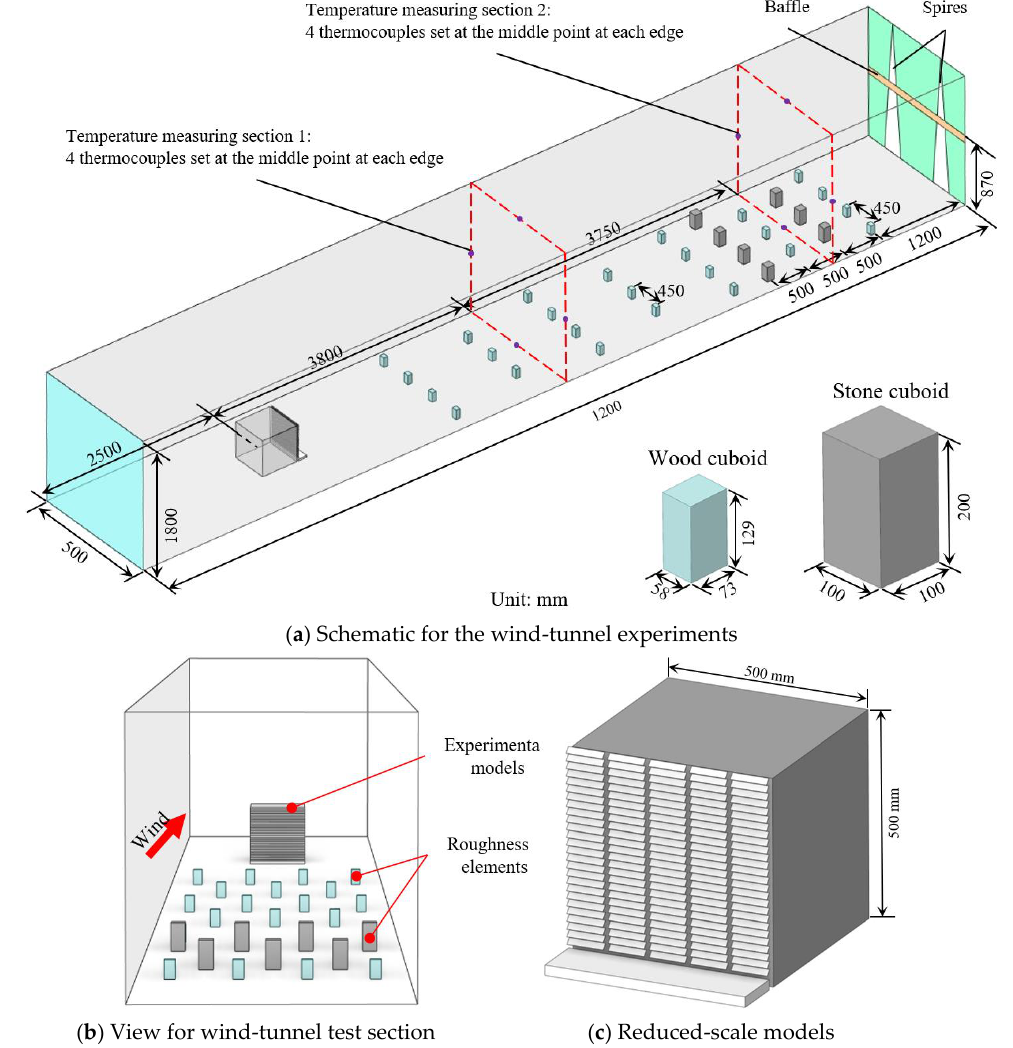
Figure 1. Set-up of the wind-tunnel experiments [21].